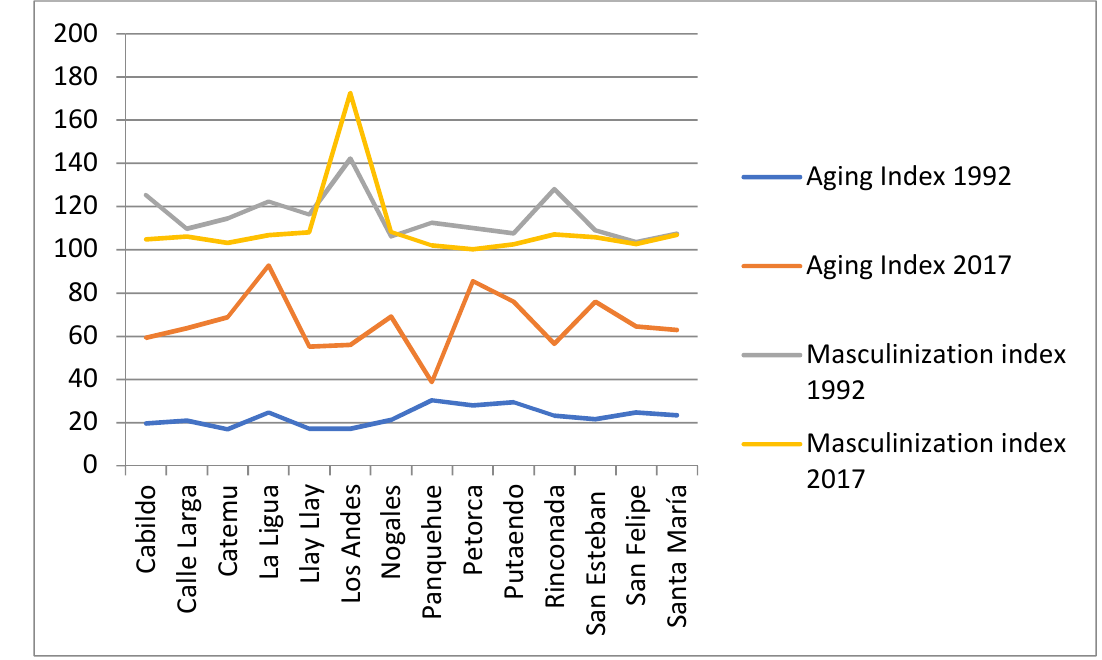
Figure 7. Aging and masculinization index, 1992–2017.